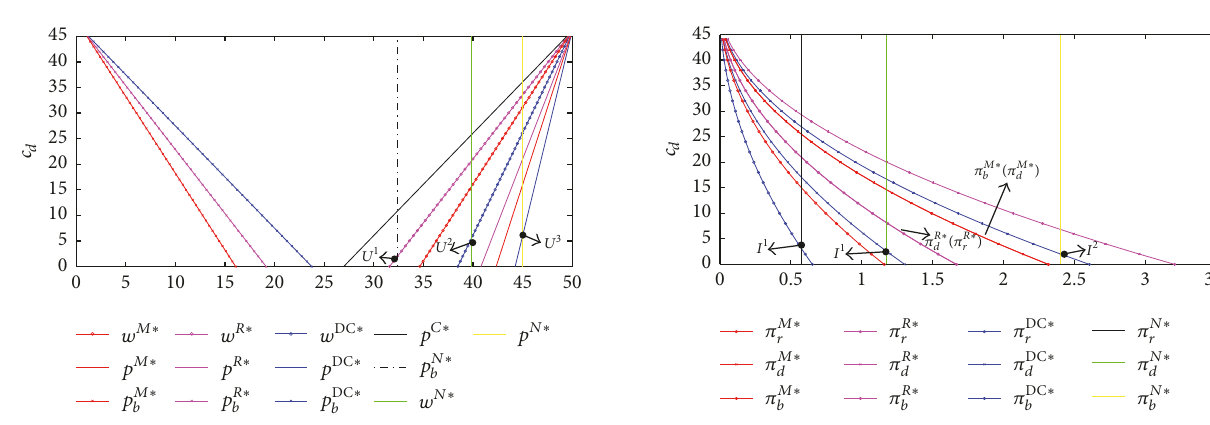
Big Data is effective in reducing production costs, benefits of supply chain members will increase.